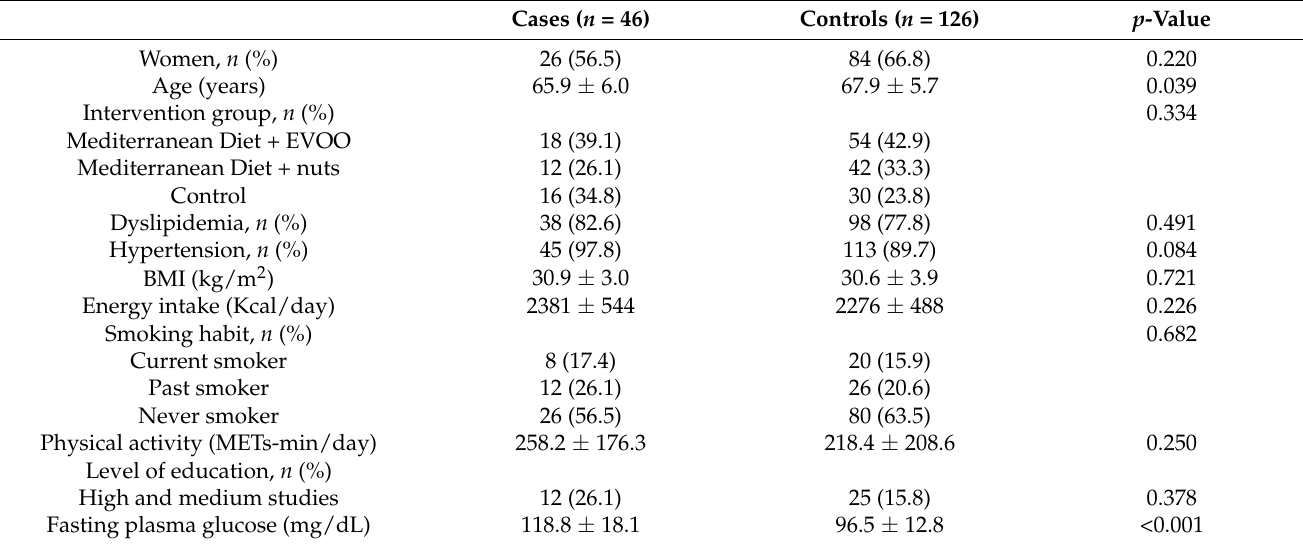
Table 1. General characteristics of the study population at baseline. Cases ( n =